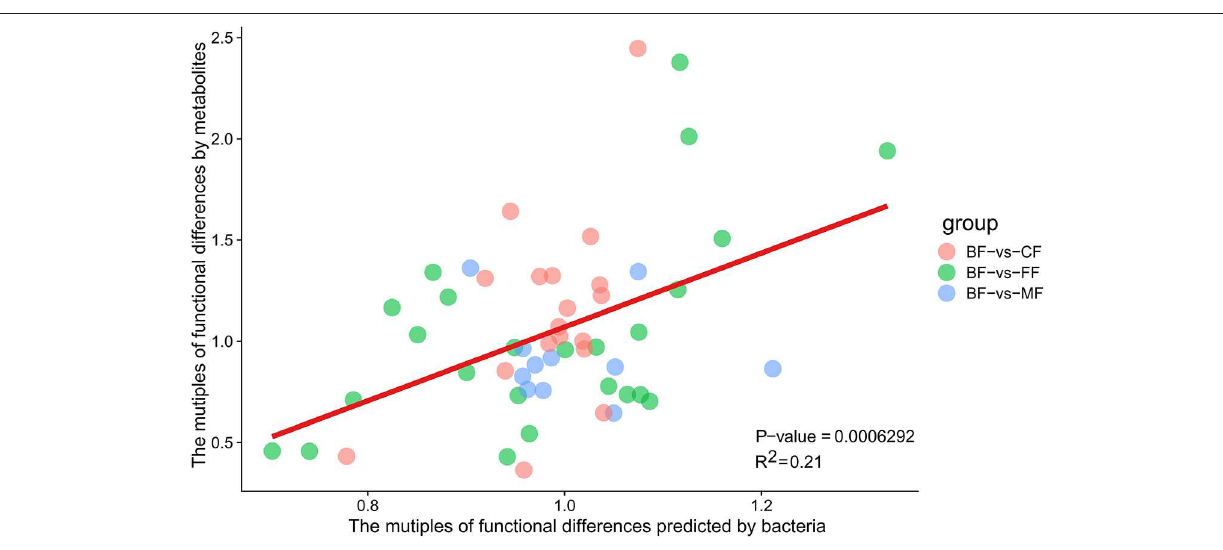
suggesting that differences of feeding methods in gut microbiota influence the metabolite milieu. The differences between exclusively BF infants and other infants were the abundance of Bifidobacterium and Lactobacillus and the abundance